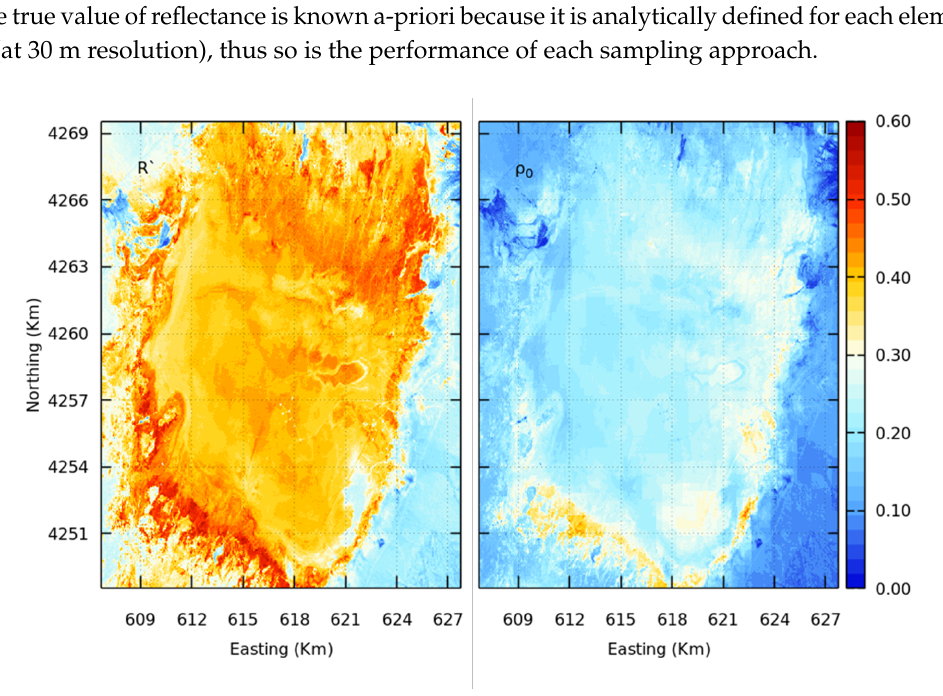
isotropic parameter as derived at 30 m 0 not shown here from MISR were M